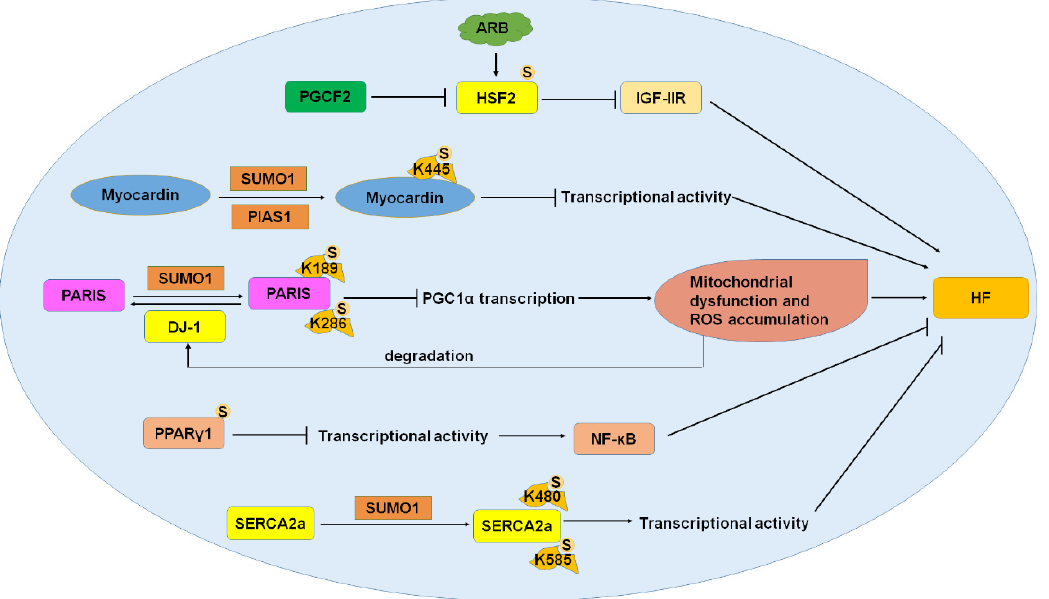
Figure 5. SUMOylation and HF. HSF2, myocardin, PARIS, PPAR γ 1, and SERCA2a were SUMOylated, and SUMOylation of these proteins played crucial roles in the progression of heart failure. HF, heart failure; HSF2, he at shock transcription factor 2; PARIS, parkin-interacting substrate; PPAR γ 1, peroxisome p roliferation activated receptor γ 1; SERCA2a, sarco- plasmic/endoplasmic reticulum Ca 2+ -ATPase 2a. S: SUMO.